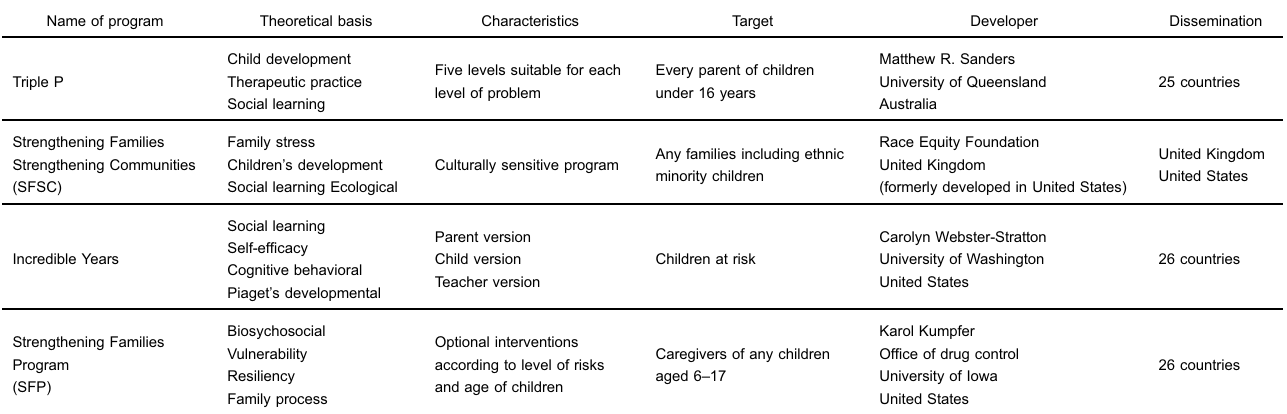
Table 4. Parenting programs implemented using a population approach Name of